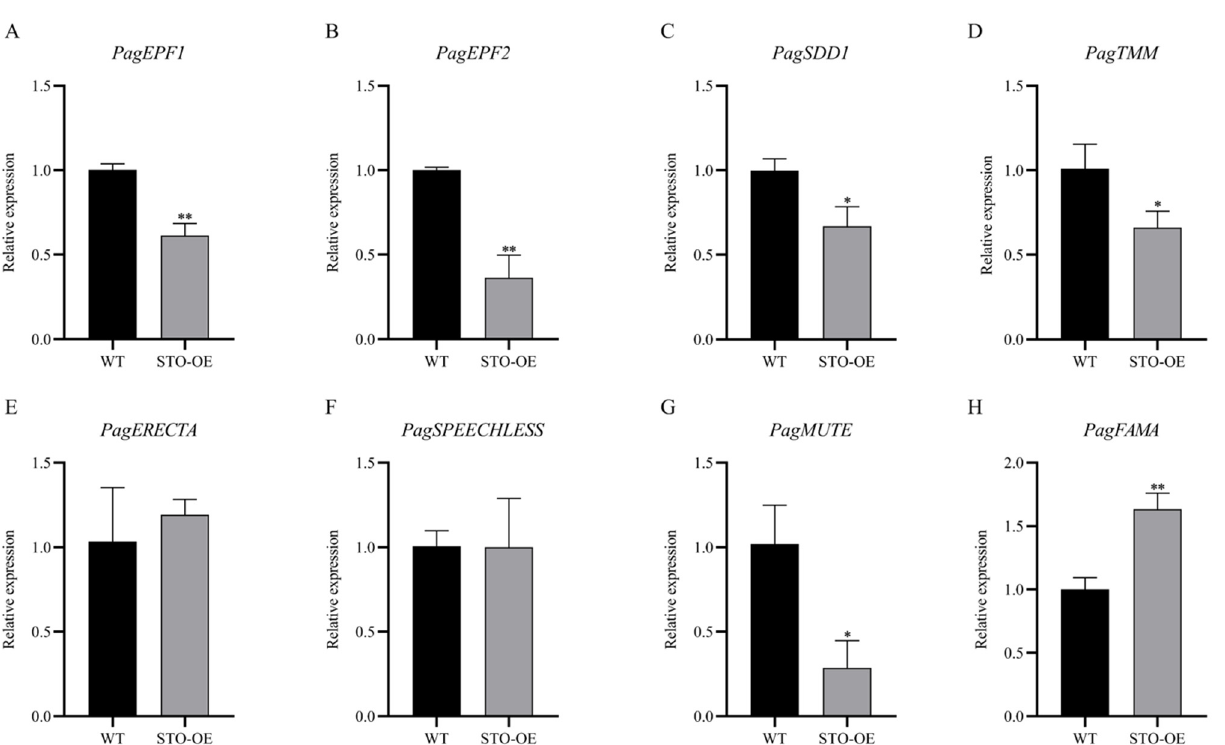
Figure 7. PagSTOMAGEN affects the expression of genes involved in stomatal development and patterning. ( A ) Relative expression level of PagEPF1 in STO-OE and WT lines. ( B ) Relative expression level of PagEPF2 in STO-OE and WT lines. ( C ) Relative expression level of PagSDD1 in STO-OE and WT lines. ( D ) Relative expression level of PagTMM in STO-OE and WT lines. ( E ) Relative expression level of PagERECTA in STO-OE and WT lines. ( F ) Relative expression level of PagSPEECHLESS in STO-OE and WT lines. ( G ) Relative expression level of PagMUTE in STO-OE and WT lines. ( H ) Relative expression level of PagFAMA in STO-OE and WT lines. Expression was estimated using RT-qPCR normalized to PagACTIN expression. Error bars represent the SD (data are the means of three biological replicates). Asterisks indicate significant differences in the Student’s t -test. ** p < 0.01; * p < 0.05.